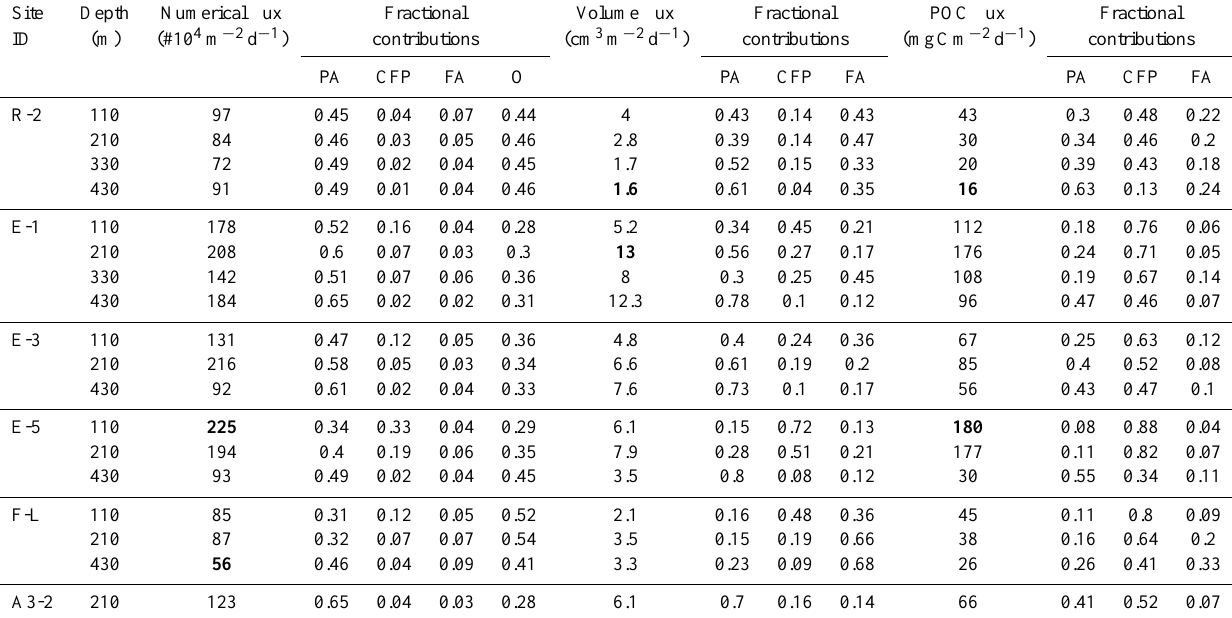
Table 3. Total numerical, volume and particulate organic carbon (POC) fluxes and fractional contributions of each category of particle. Maximum and minimum fluxes are indicated in bold. PA: phytodetrital aggregates; CFP: cylindrical fecal pellets; FA: fecal aggregates; O: